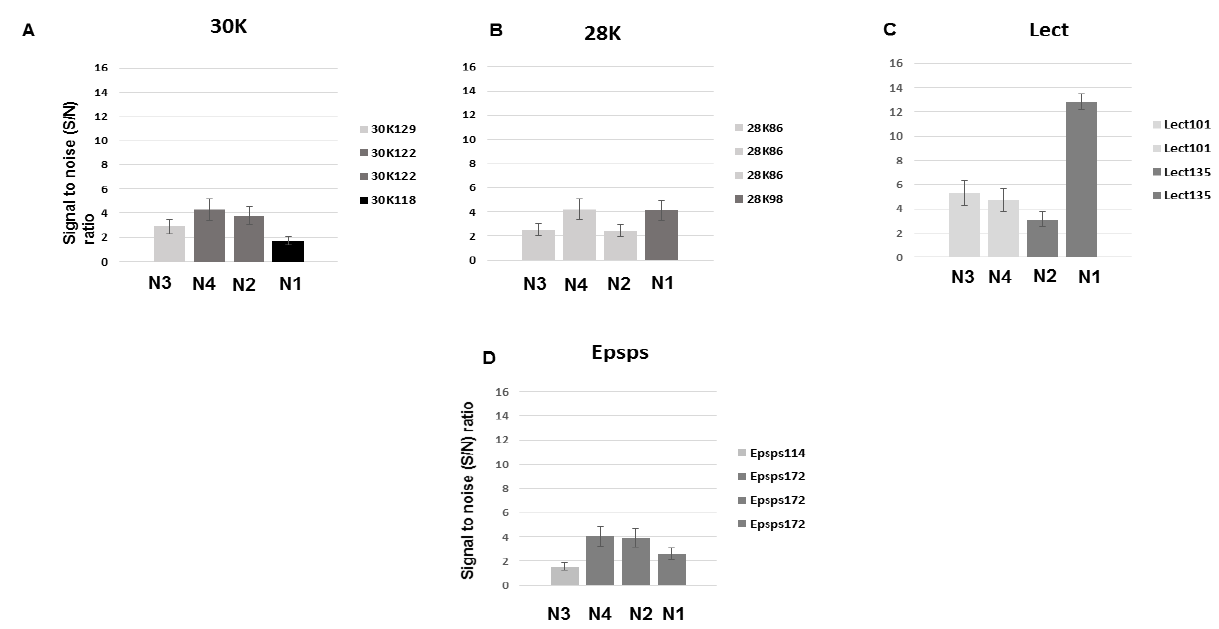
Figure 9. The analysis of DNA chips for GM soya allergens 30K, 28K, lectin and epsps. The hybridization capacity of the probes: 30K118, 30K122, and 30K129 ( A ); 28K86 and 28K98 ( B ); Lect101 and Lect135 ( C ); Epsps114 and Epsps172 ( D ).